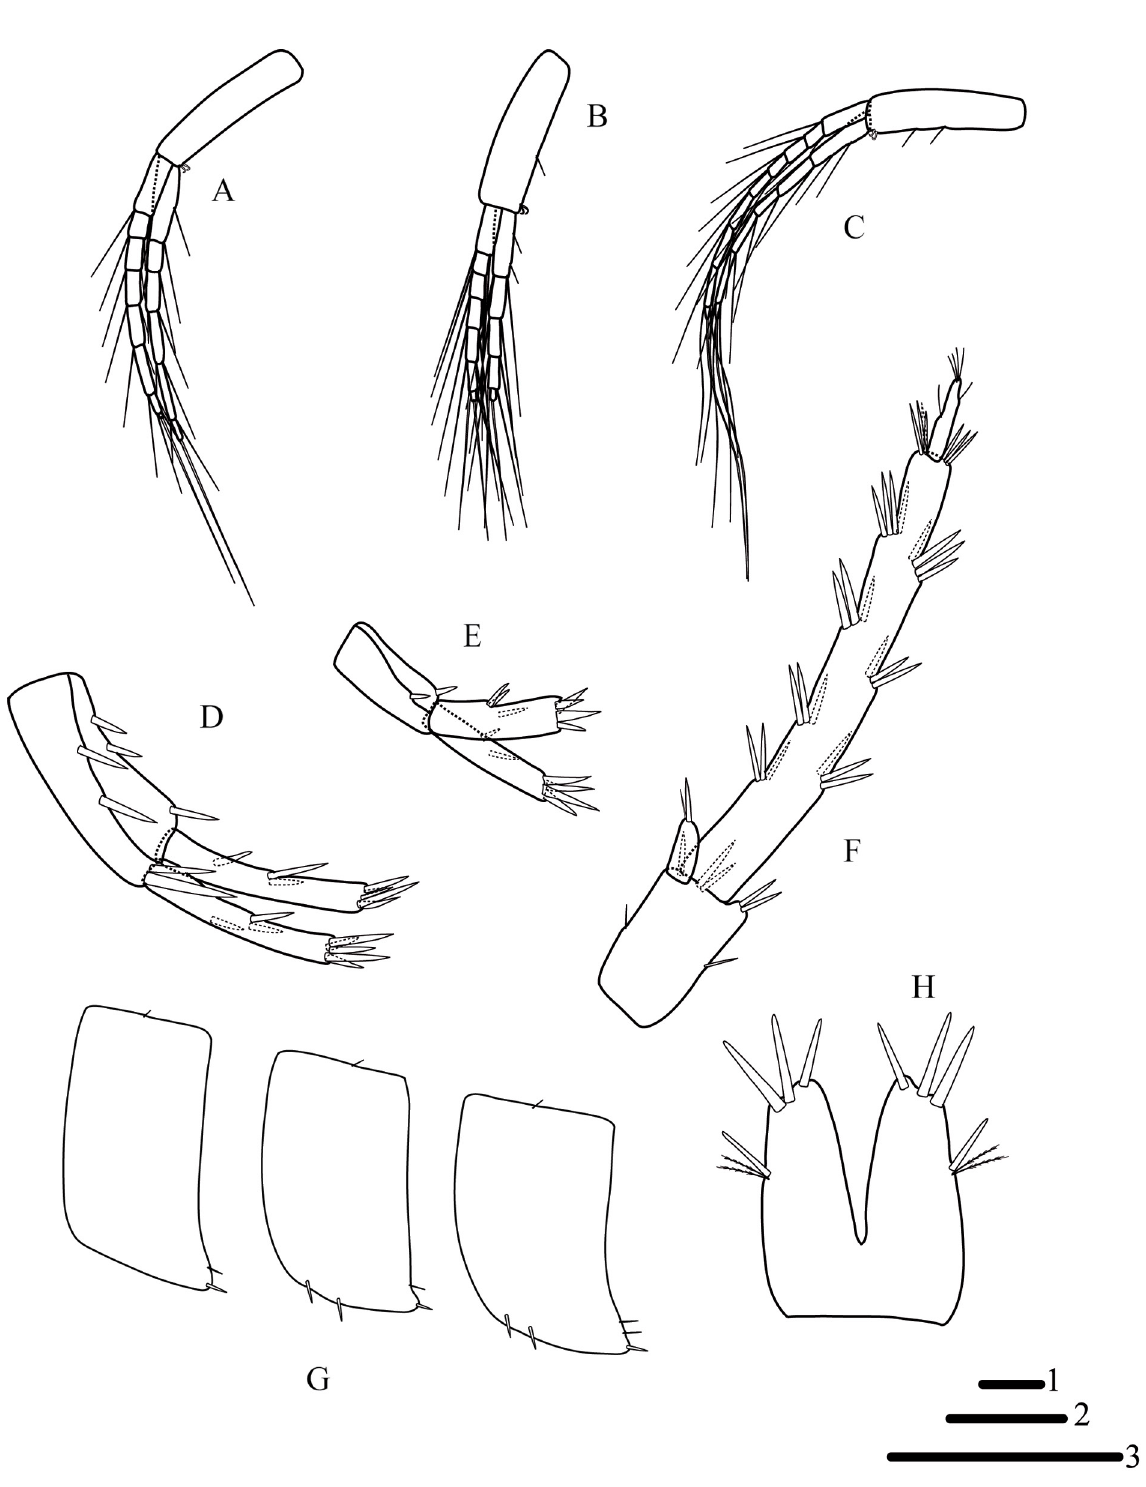
Fig. 10. Niphargus fiseri sp. nov., holotype, ♂, 8 mm (ZCRU Amph.1073). A . Pleopod I. B . Pleopod II. C . Pleopod III. D . Uropod I. E . Uropod II. F . Uropod III. G . Epimeral plates. H . Telson. Scale bars: 1 = 0.5 mm (G–H); 2 = 1 mm (A–E); 3 = 2 mm